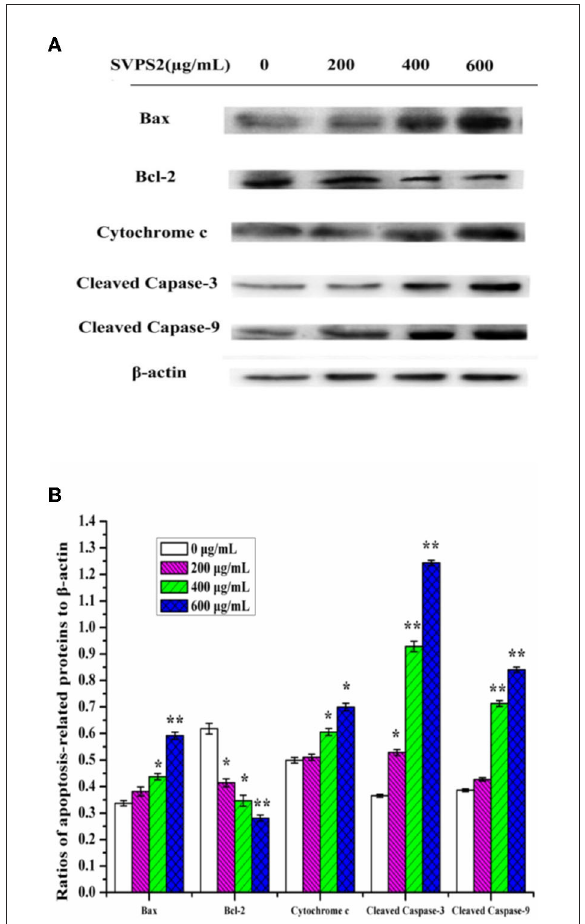
FIGURE10 (A) Expressions of proteins of SVPS2-treated HT-29 cells. (B) Relative protein levels were expressed normalized to β -actin. The * symbol indicate the values of p < 0.05 and the ** symbol indicate the values of p < 0.01 compared to the control